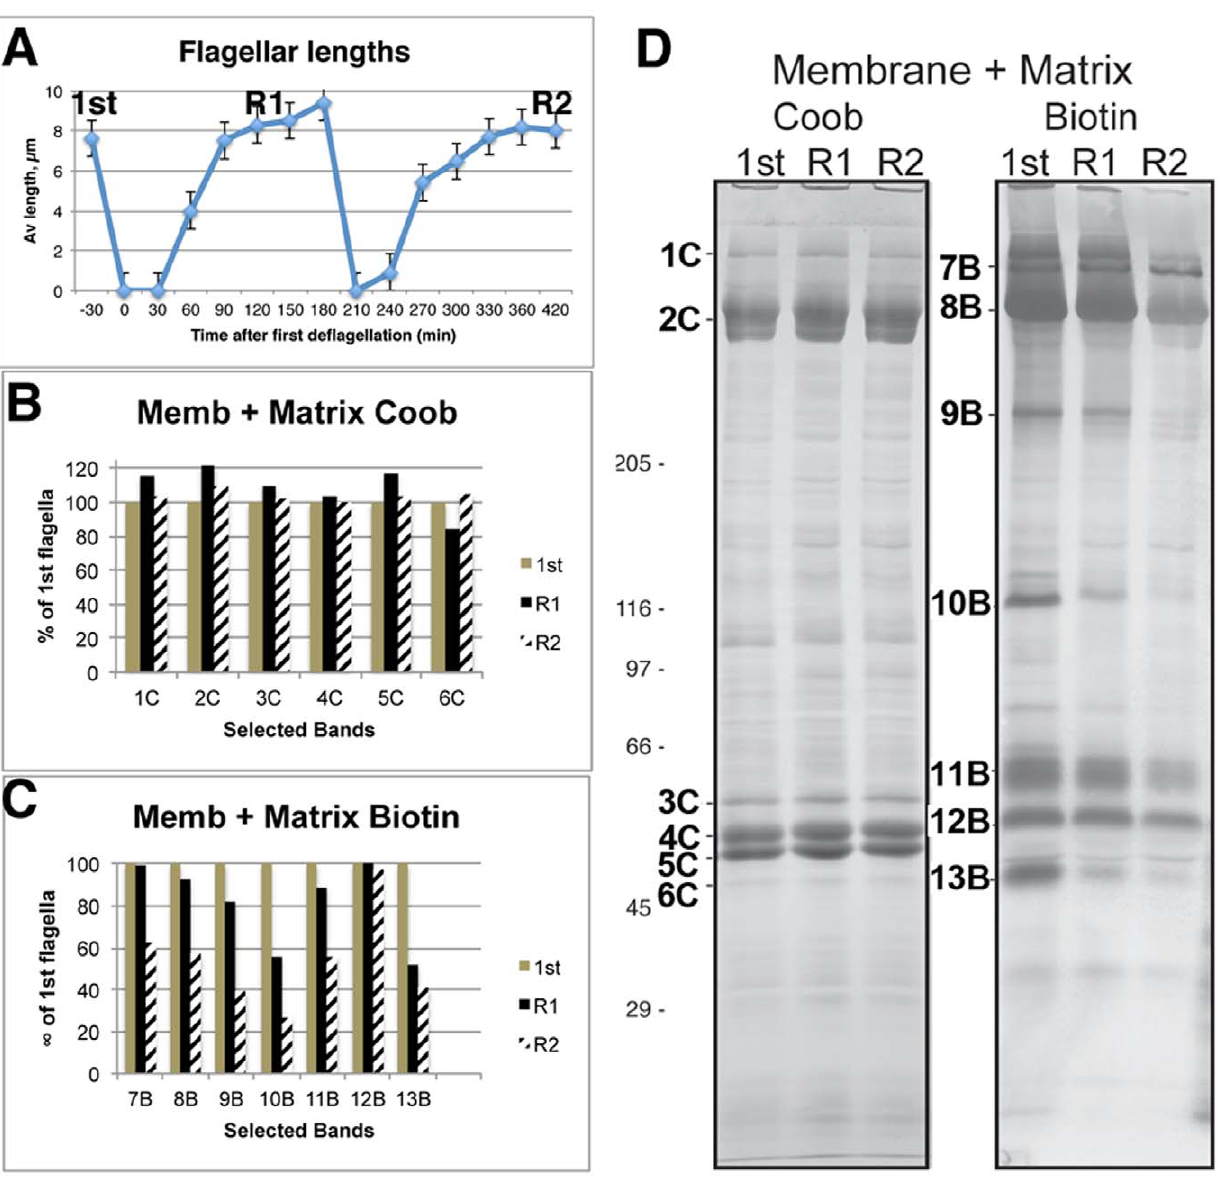
Figure 4. A pool of flagellar surface proteins on the plasma membrane can supply regenerating flagella. Cells were biotinylated and flagella were isolated from the freshly biotinylated cells (1 st ). Cells regenerated flagella, deflagellated (R1), and regenerated flagella a second time (R2). A: Flagellar lengths before the first deflagellation (1 st ), first (R1) and second (R2) regeneration. B–D: Membrane + Matrix stained with CB or blotted and stained with AP-streptavidin (Biotin). Density of selected bands stained with CB (1C–6C) or AP-streptavidin (6B–13B) presented as a percentage of the density of the bands in flagella isolated immediately after biotinylation (1 st ). Coomassie blue stained proteins in each fraction were nearly identical (B) but the quantity of biotinylated protein decreased with each regeneration (C), indicating that the pool of biotinylated protein was gradually depleted as flagella grew.